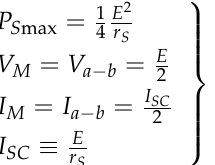
Figure 1. DC source with internal resistance r s loaded by resistor R L .